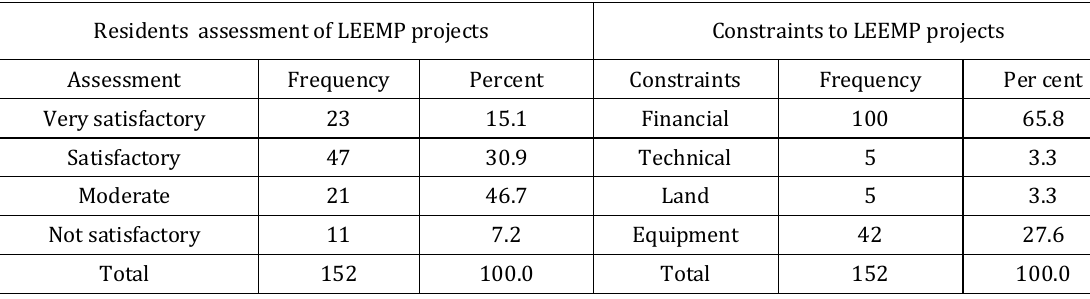
Table 5. Performance assessment and constraints of the LEEMP Projects